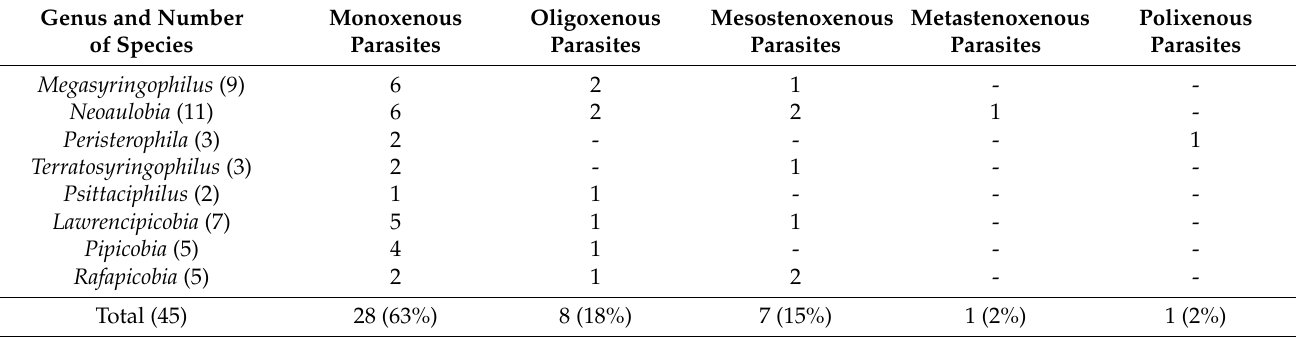
Table 7. Host specificity of quill mites associated with